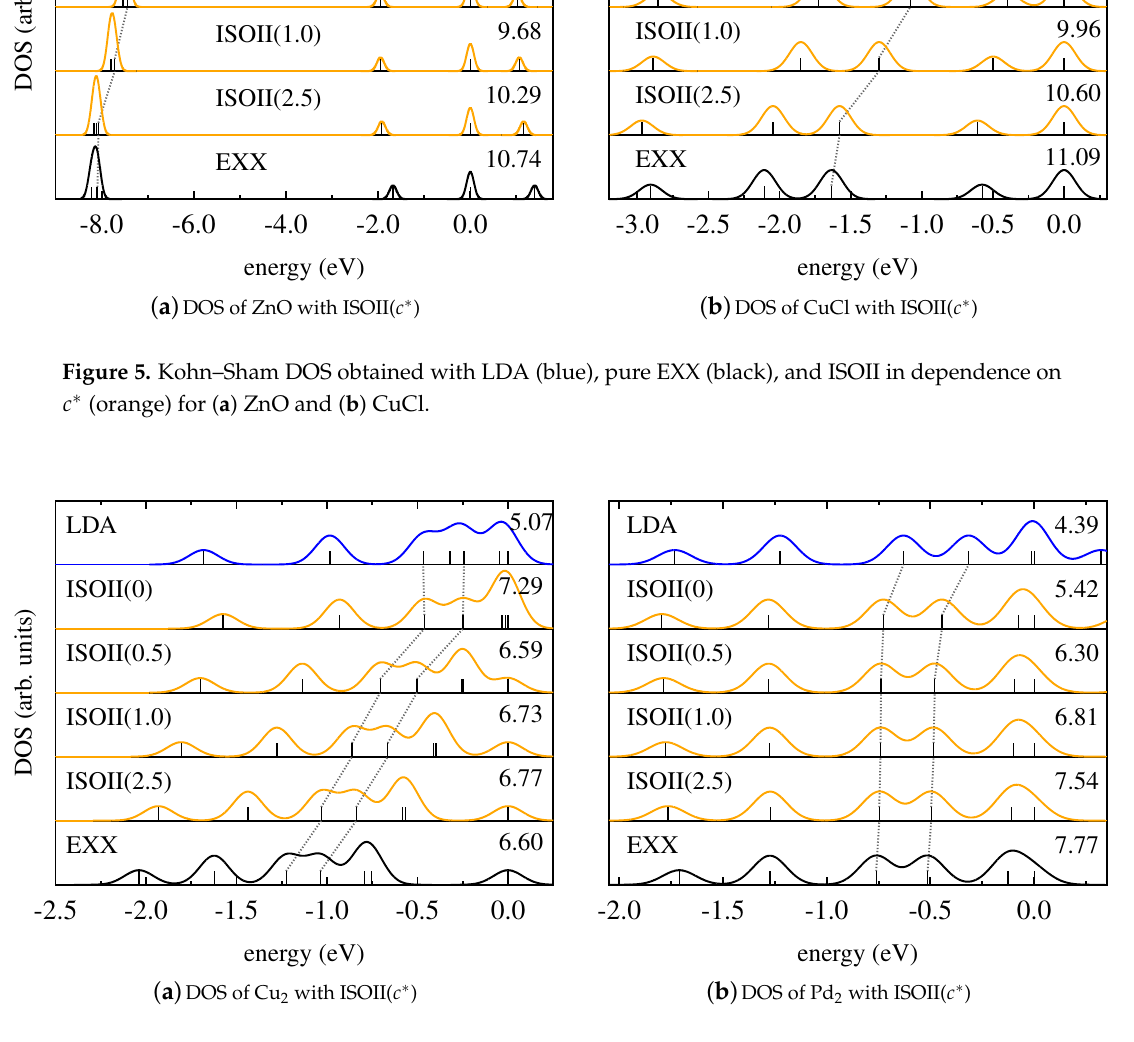
Figure 6. Kohn–Sham DOS obtained with LDA (blue), pure EXX (black), and ISOII in dependence on c ∗ (orange) for ( a ) Cu 2 and ( b ) Pd 2